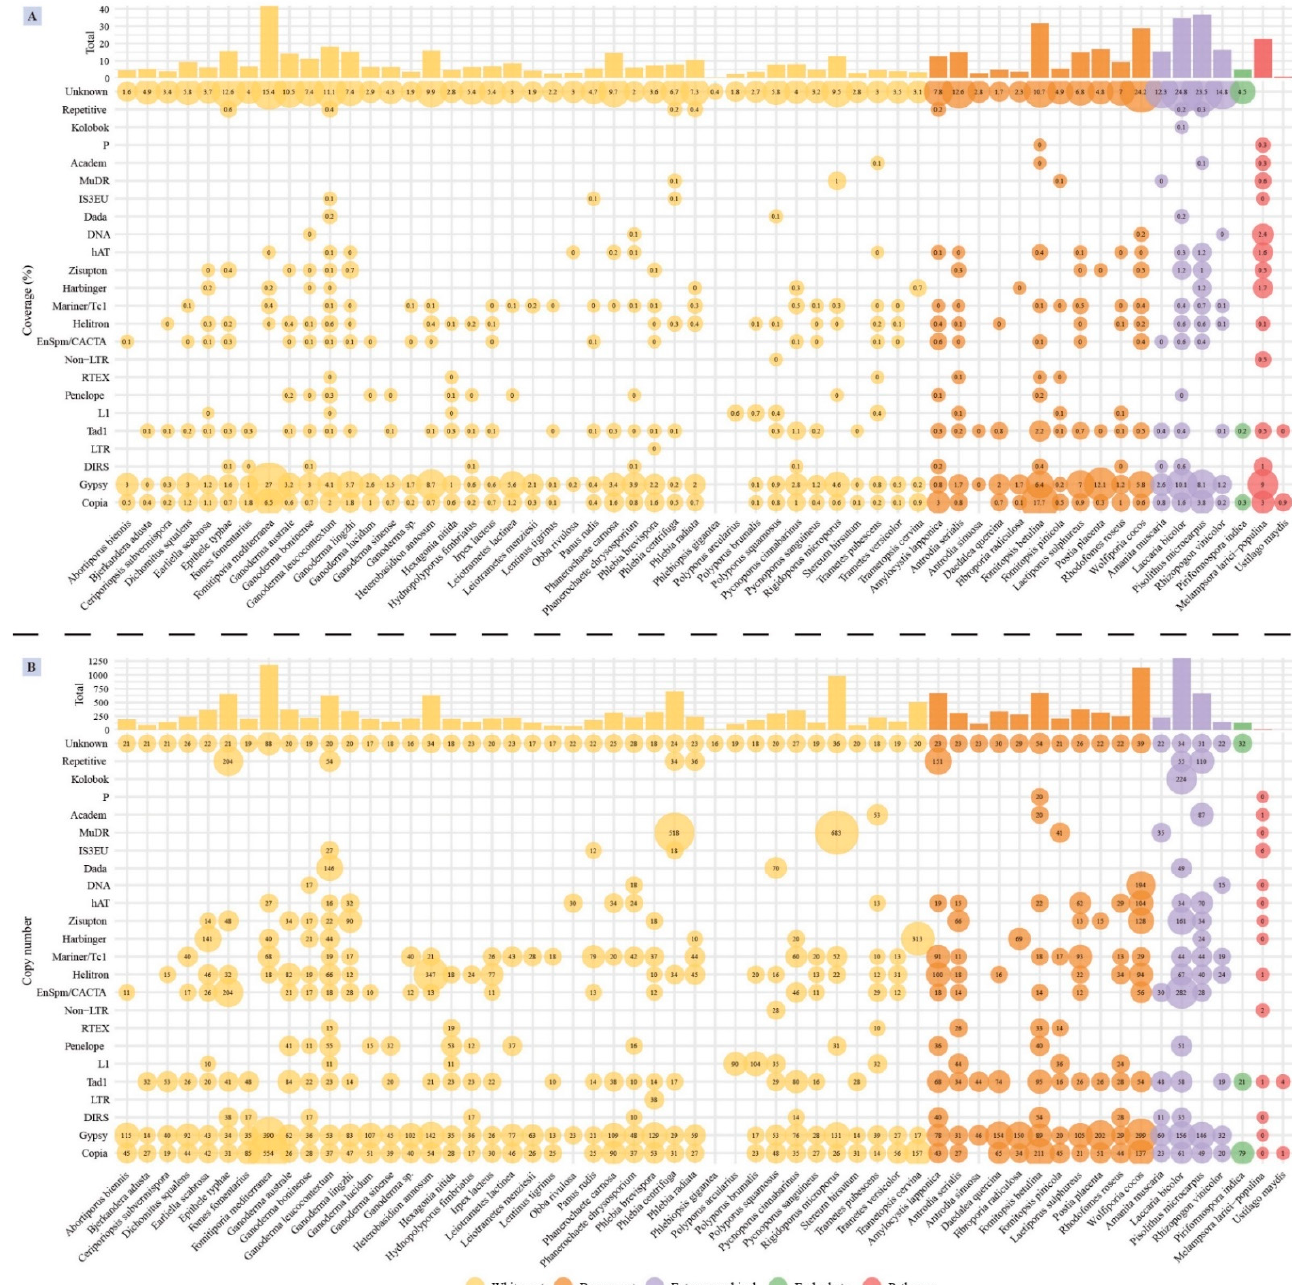
Figure 4. ( A ) Distribution and coverage of transposable elements (TEs) identified in the 58 selected genomes. The bubble size is proportional to the coverage of each of transposable elements (shown inside the bubbles). The bars on top show the total coverage per genome. ( B ) The copy number of transposable elements (TEs) identified in the 58 genomes. The bubble size is proportional to TE copy number (shown inside the bubbles). The bars on top show the total copy number per genome. Color codes for the five fungal lifestyles are shown at the bottom of the figure. TE coverage in the 58 analyzed genomes ranged from 0.37% ( Phlebiopsis gigantea ) to 41.69% ( Fomitiporia mediterranea ) (Table S4). Comparing to other lifestyle fungi, white-rot fungi have low TE coverage except F. mediterranea ( p < 0.01), among which Ganoderma spe- cies have relatively higher TE coverage ( p < 0.05). Ectomycorrhizal fungi showed the larger repeat element coverage, in which unknown TE elements were the most abundant (>12%).